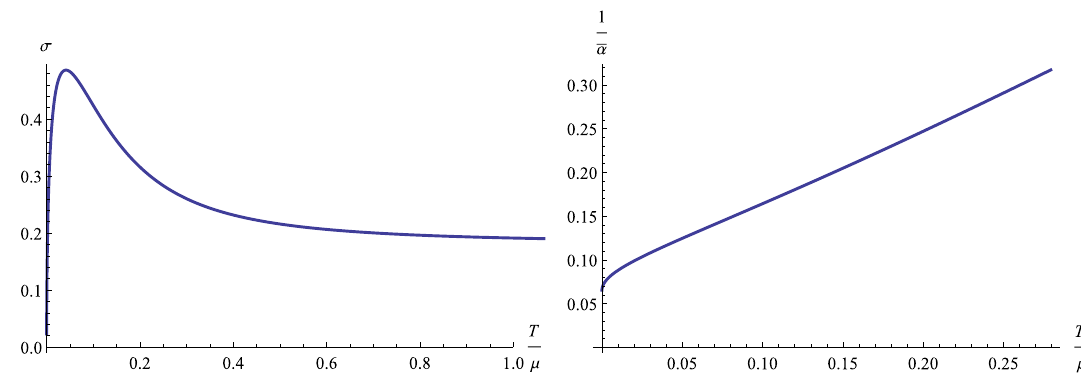
Figure 8 . Electric conductivity (cid:27) and thermal resistivity 1 = (cid:22) (cid:11) as a function of the